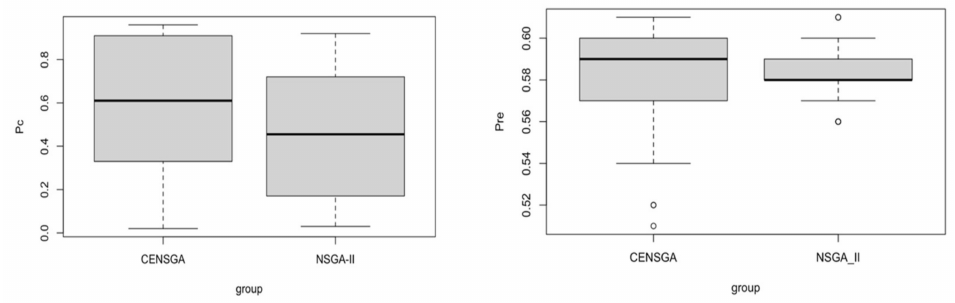
Figure 13. Mean values of P C and P RE